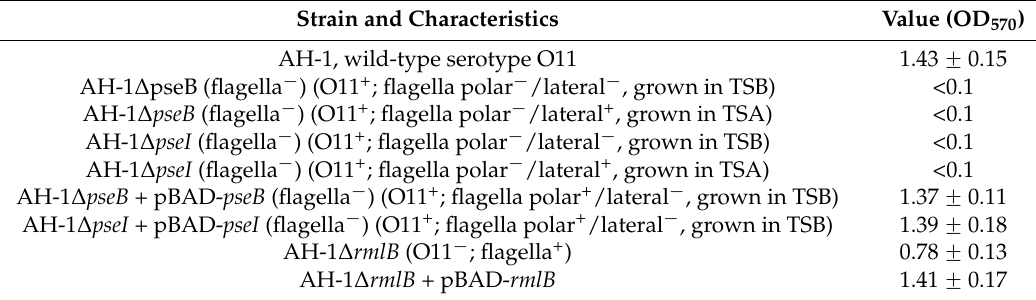
Table 2. Biofilm values of several A. hydrophila AH-1 serotype O11 strains using the method of Pratt and Kolter as indicated in the Experimental Section. Values presented are mean ˘ SD from three independent experiments carried out in triplicate ( n = 9).